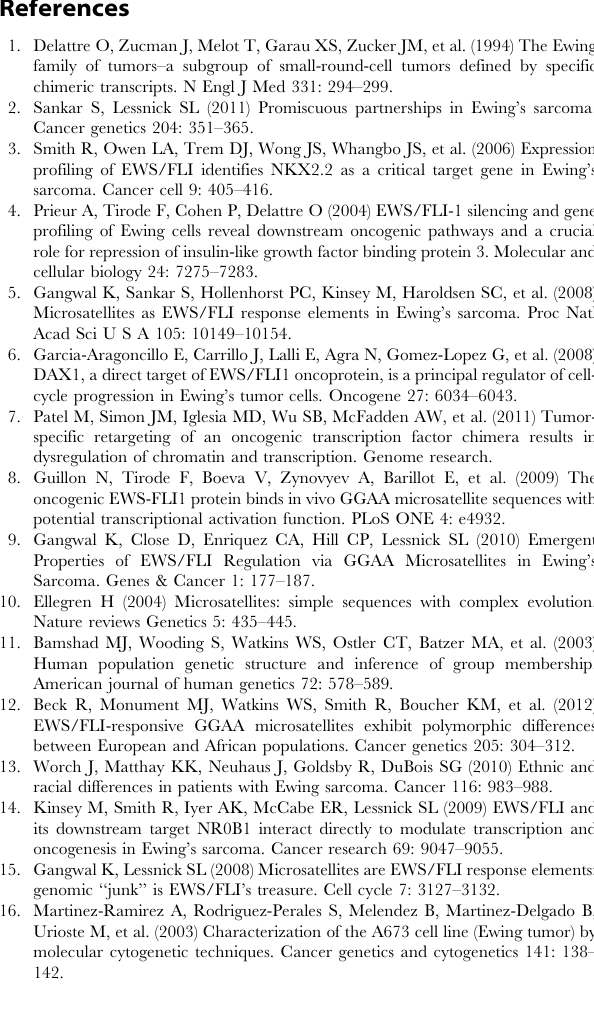
Table S1 Complete sequence data of NR0B1 GGAA-microsat- ellites form all samples. In the ‘‘COG Data’’ tab all data from Children’s Oncology Group primary tumor samples are included. The data fields indicate the zygosity, the number of GGAA repeats for each allele, the segment characteristics of each allele, and the raw sequence of each allele. In the ‘‘African Data’’ and ‘‘European Data’’ tabs, all data from the African and European subjects, respectively, are included. The data from these latter tabs were previously described in reference